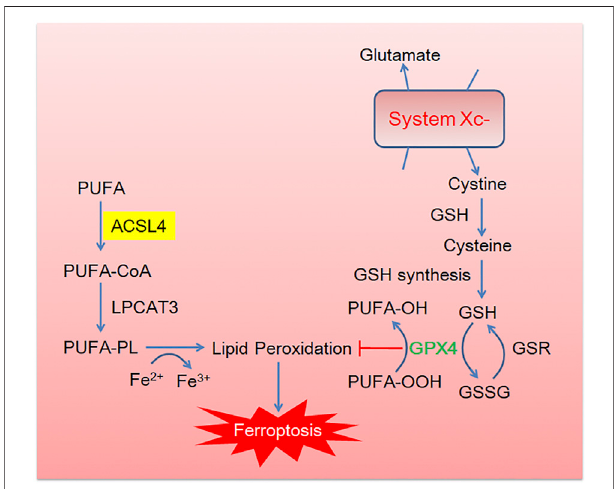
FIGURE 1 | The brief description of canonical ferroptosis pathway. Cystine enters into cells through the cystine/glutamic acid reverse transporter (System Xc-) and then reduces to cysteine in the glutathione (GSH). GSH acts as a cofactor of glutathione peroxidase 4 (GPX4) to promote the reduction of phospholipid hydroperoxides (PLOOHs) to corresponding alcohols (PLOHs) in cells. Essential lipid peroxidase acyl-CoA synthase long chain family member 4 (ACSL4) and lysophosphatidylcholine acyltransferase (LPCAT) activatePUFA intoPUFA-CoA and PUFA-PL,respectively,leadingto lipid peroxidation.